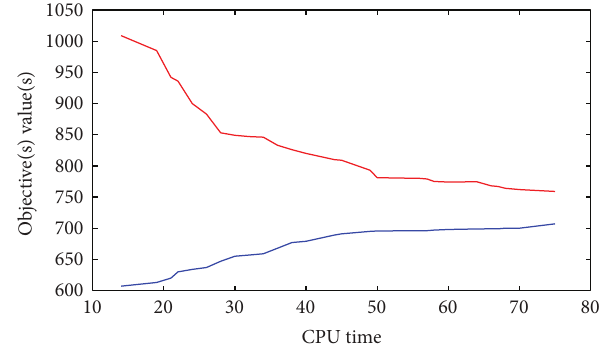
Figure 3: Objective and dual bound progress of some decomposi- tion application for a distribution MMN corresponding to dataset 2 from Table 2 (the objective value descends from above and the dual bound ascends from